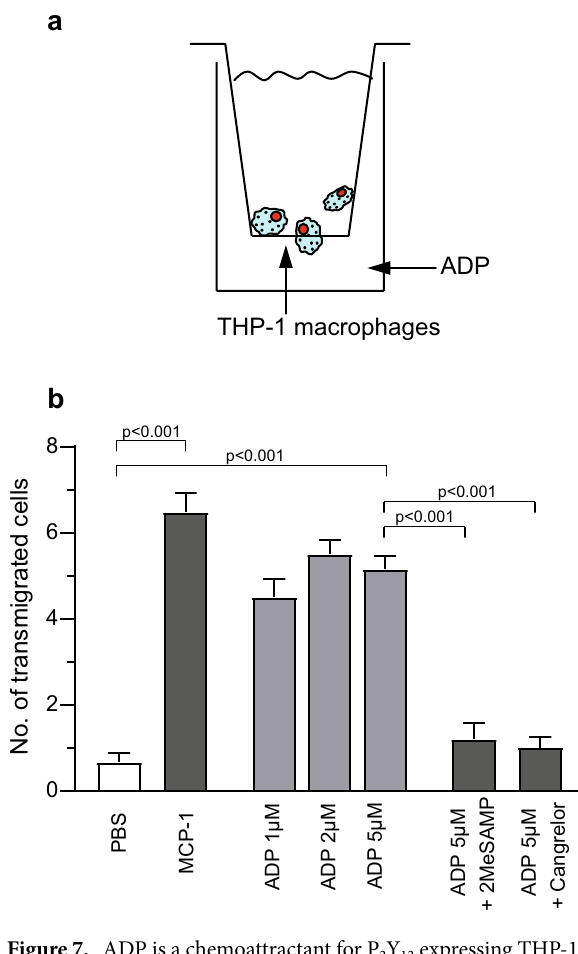
Figure 7. ADP is a chemoattractant for P 2 Y 12 expressing THP-1 macrophages. ( a ) Principle of the transwell assay. More information can be found in the “Methods” section. ( b ) It was found that THP-1 macrophages showed increased migration towards ADP compared to PBS. This migratory behaviour was inhibited by different P 2 Y 12 receptor blockers. MCP-1 served as a positive control. n = 5, data are presented as mean ± SEM. p -values were calculated by one-way